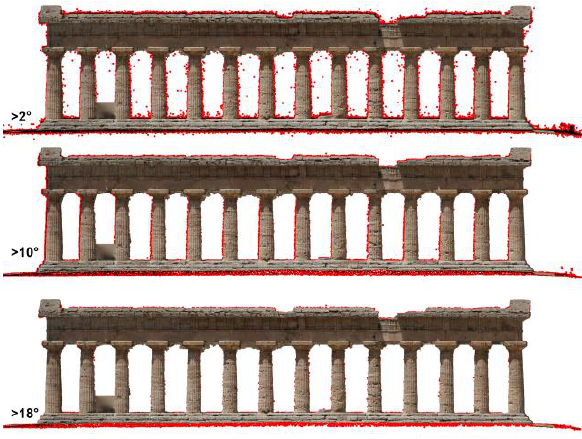
Figure 6. Filtering of the average angle between homologous points for assigned angular values.